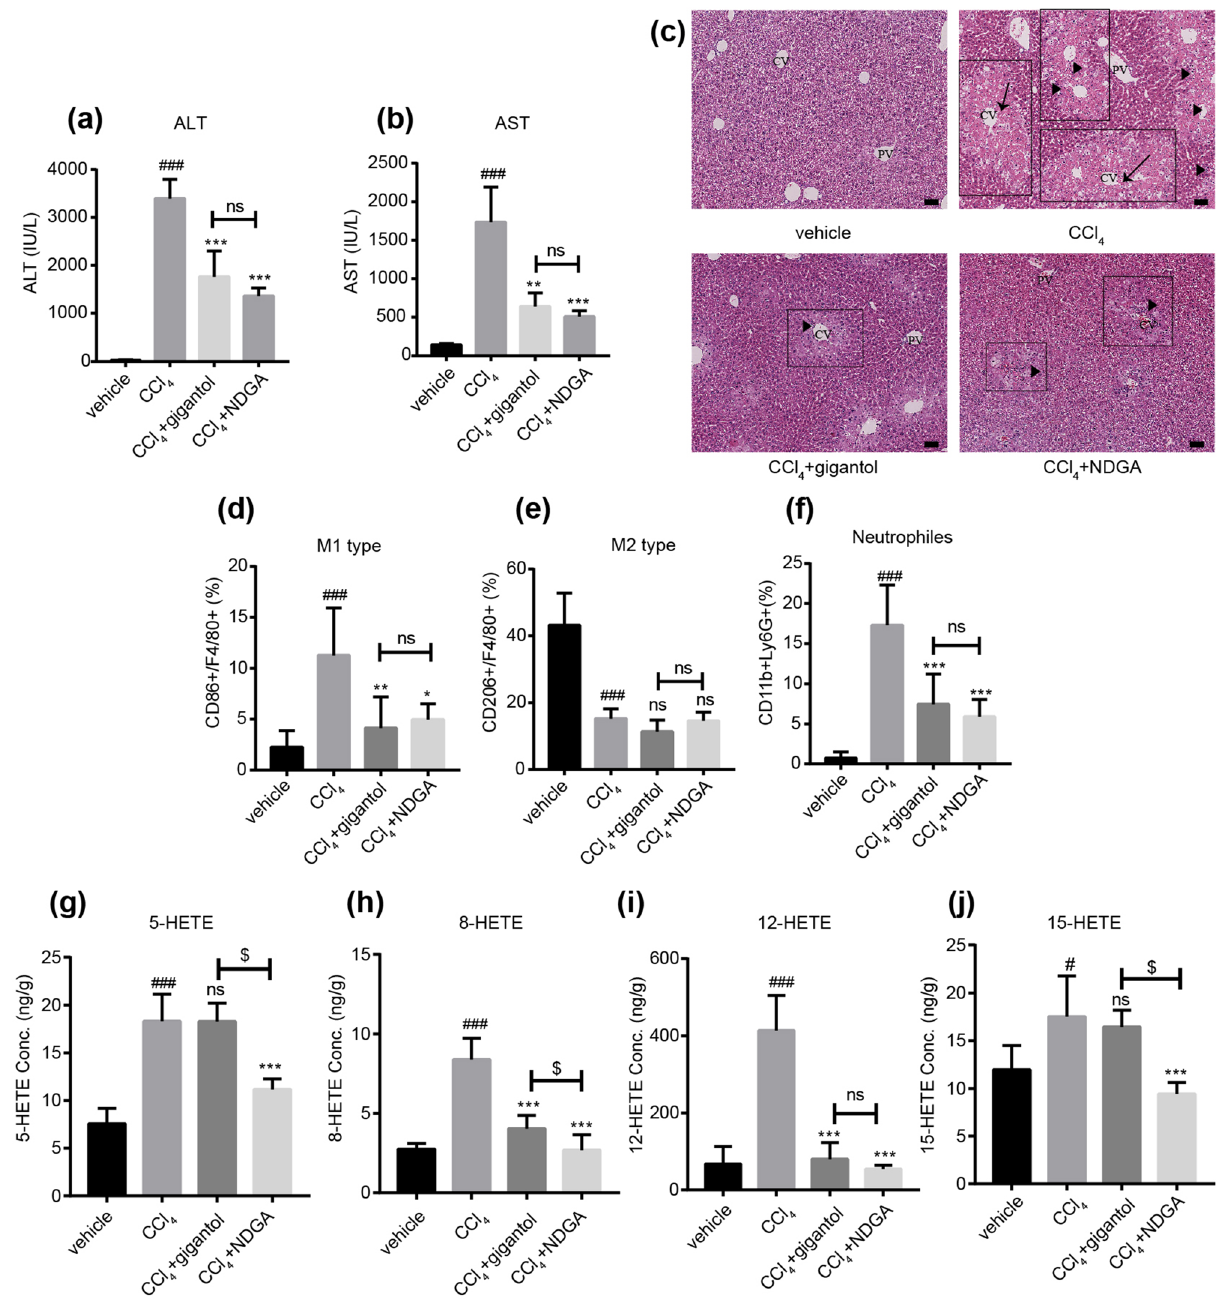
Figure 6. LOX inhibitor NDGA alleviated liver inflammation to the same extent as gigantol. ( a ) Serum ALT and ( b ) AST levels in mice with or without gigantol or NDGA (40 mg kg −1 d −1 , po , for 7 days) pretreatment were measured 16 h post CCl 4 injection. ( c ) Representative histological sections of liver tissues were stained with H&E. Symbols: black arrow-centrilobular necrosis; rectangle-tumefaction and steatosis; solid triangle- inflammatory infiltration. CV-centrilobular veins; PV-portal veins. The percent of ( d ) M1-type macrophages (CD86+F4/80+), ( e ) M2-type macrophages (CD206+F4/80+) and ( f ) neutrophils (CD11b+Ly6G+) were detected by FACS. The concentration of ( g ) 5-HETE, ( h ) 8-HETE, ( i ) 12-HETE, and ( j ) 15-HETE were quantified with UPLC/MS/MS. The above results are shown as the mean ± SD, n = 6 in each group. ### P < 0.001, # P < 0.05 versus the vehicle group; ** *P < 0.001, * *P < 0.01, *P < 0.05 versus the CCl $$$ P < 0.001, $ P < 0.05 4 group; (CCl 4 + gigantol) versus (CCl 4 + NDGA); ns means non-significance; ns means